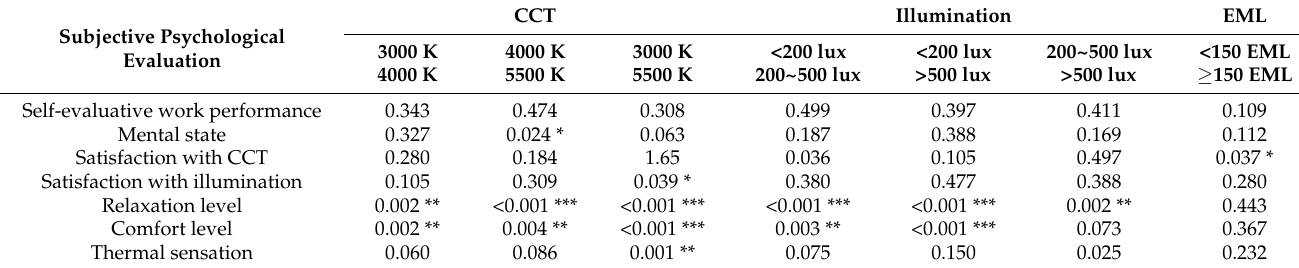
Table 2. Significant ( p ) results of T -test for subjective psychological evaluation.